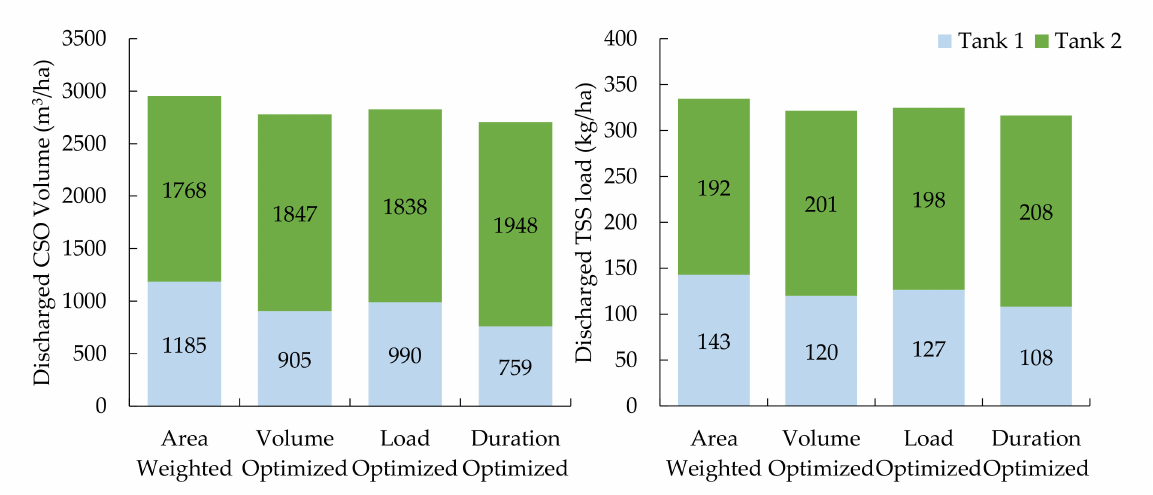
Figure 4. Emitted connected area specific combined sewer overflow (CSO) volume (left) and total suspended solid (TSS) load (right) from both CSO tanks for area weighted and optimized controlled